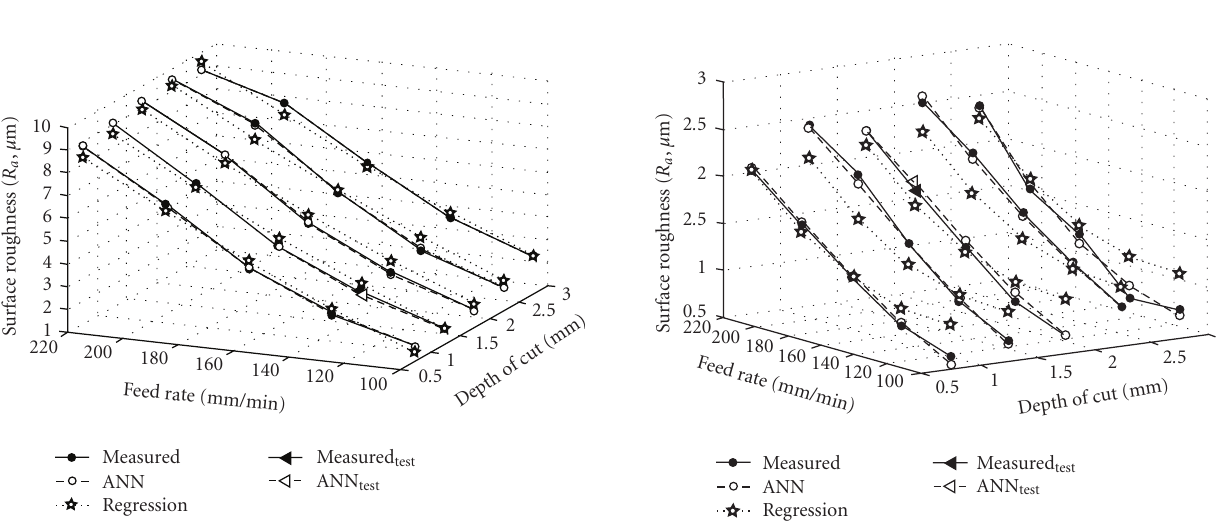
Figure 15: Comparison of actual, regression, and ANN approach values for insert radius of 0.4 mm.